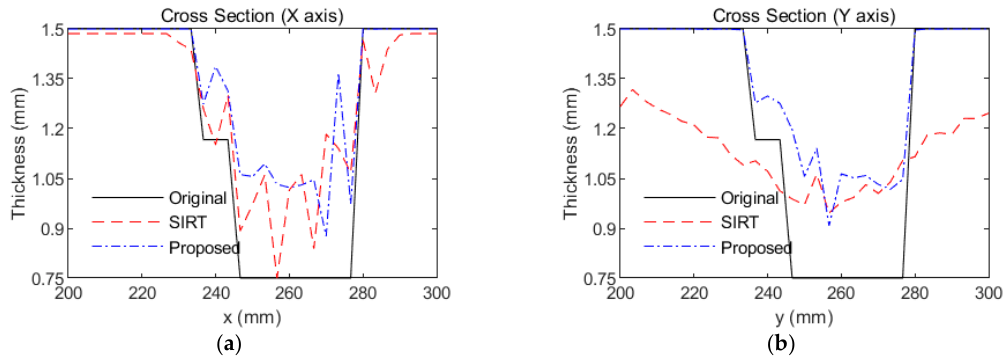
Figure 12. Cross section of reconstruction of three circular flat-bottomed holes following the lines marked in Figure 11a along ( a ) the horizontal line and ( b ) the vertical line.